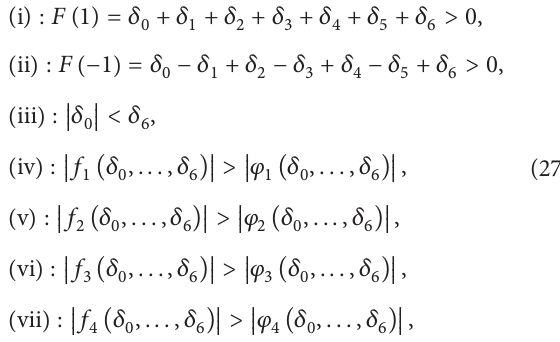
𝐸 , . . . , 𝐸 0 6 are boundary equilibrium points; unique Nash equilibrium point. The Jury conditions are